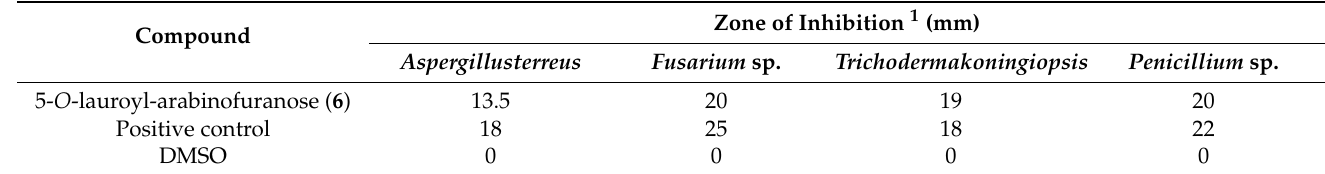
Table 3. Antifungal activity of 5- O -lauroyl- L -arabinofuranose at 0.5 mg/disc. Zone of Inhibition 1 (mm) Compound Aspergillusterreus Fusarium sp. Trichodermakoningiopsis Penicillium